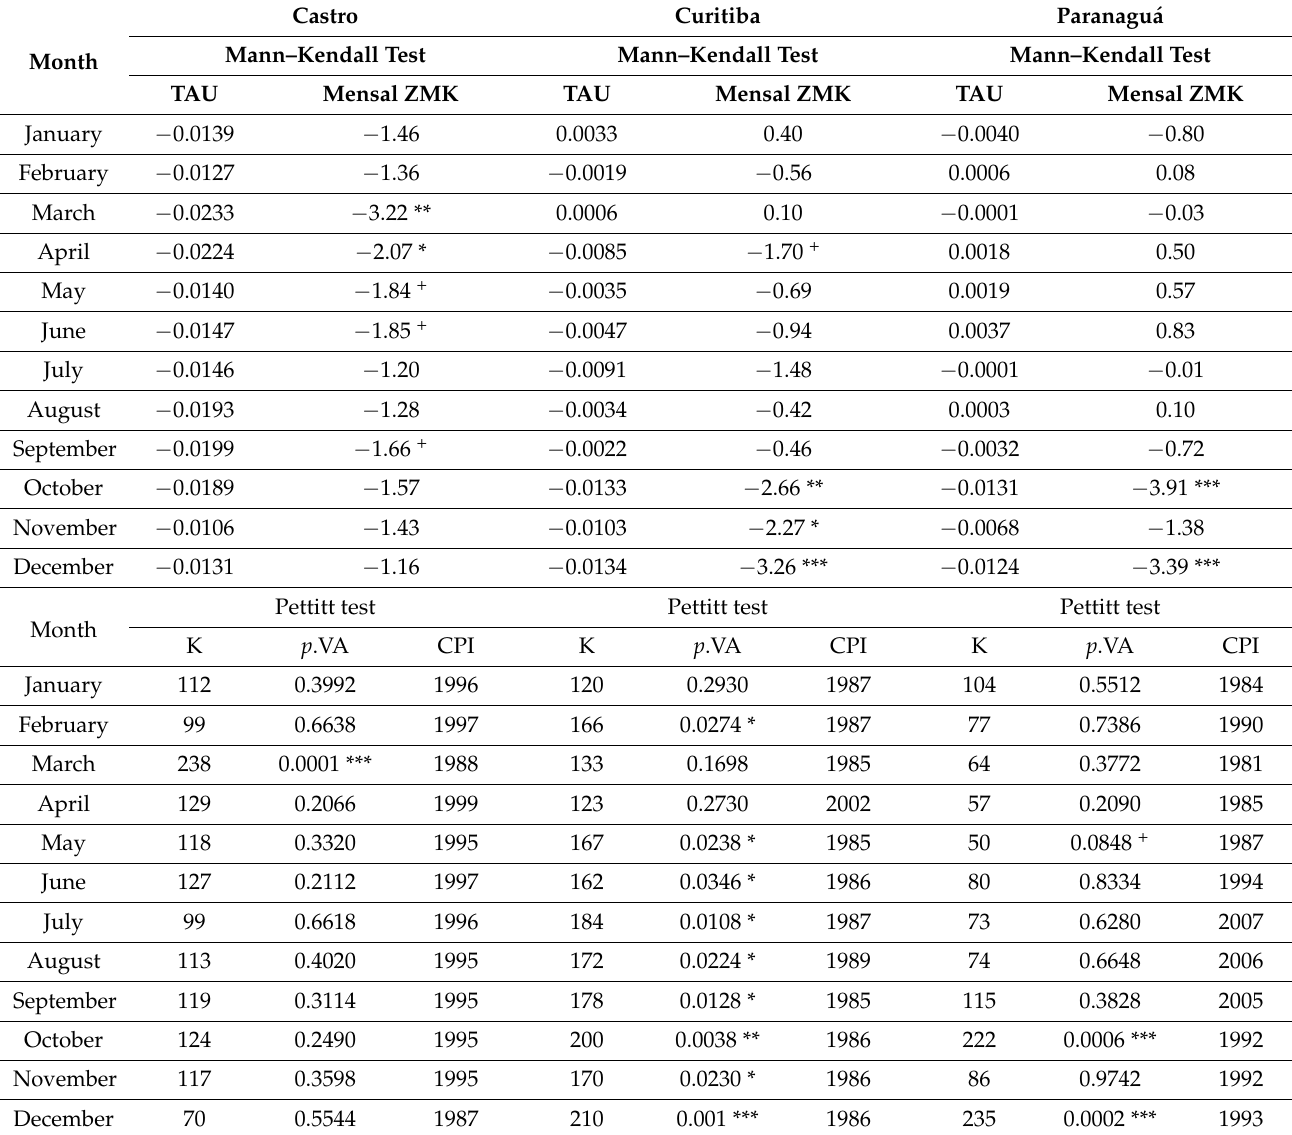
Table 6. Monthly wind speed trend ( ZMK ) according to the Mann–Kendall test and break point detection (CPI) of Pettitt